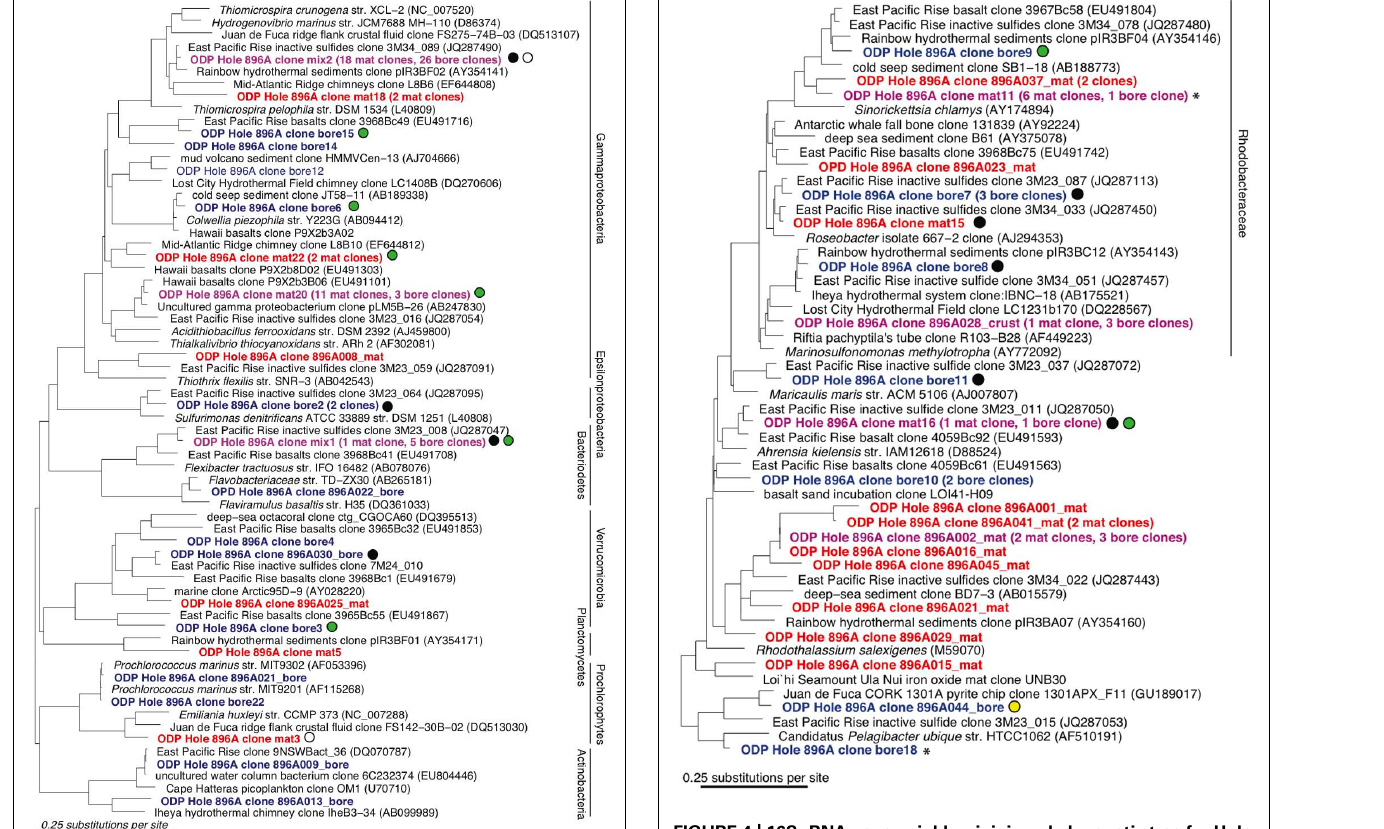
FIGURE 4 | 16S rRNA gene neighbor-joining phylogenetic tree for Hole 896A observatory bore and mat sampleAlphaproteobacteria sequences in comparison to close relatives from the GenBank database. Same details as for Figure 3